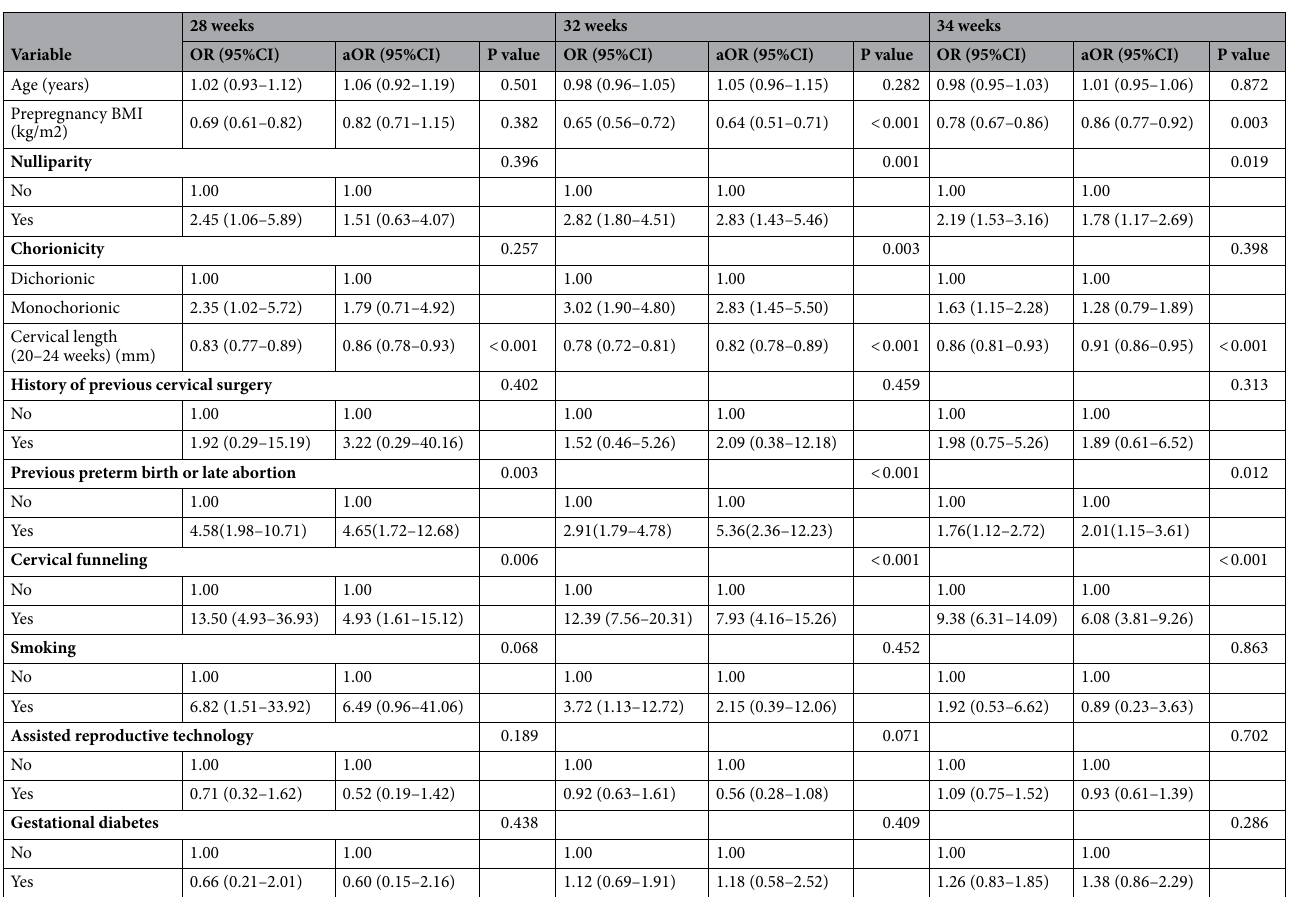
Table 2. Multivariate (adjusted) OR, 95% CI and P values according to the probability of PTB before 28 weeks, 32 weeks, and 34 weeks in the training group (n = 727). OR odds ratio, CI confidence